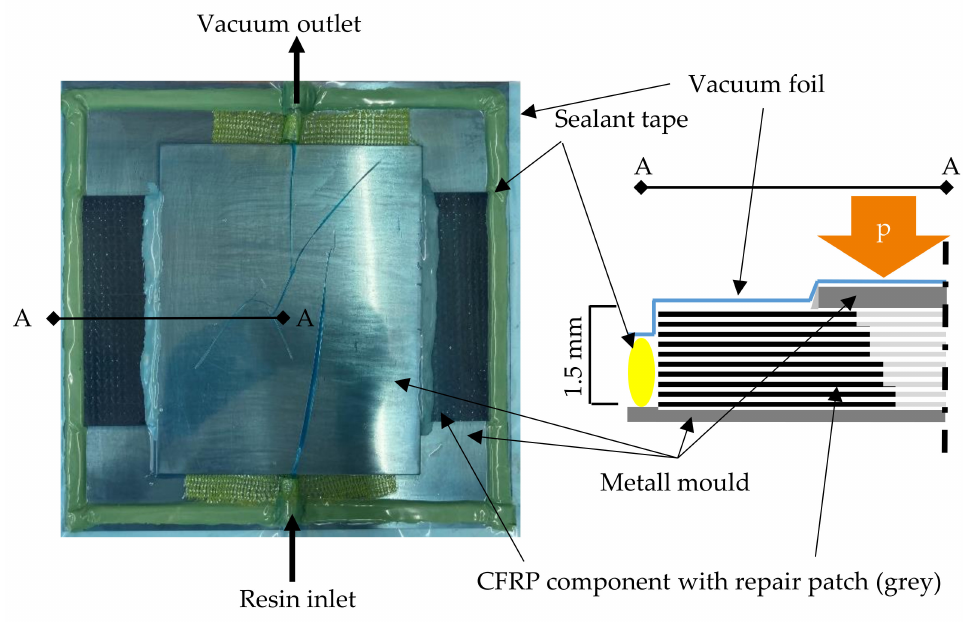
Figure 4. VARI re-infiltration setup for CFRP repair with textile patches. Within the study, CFRP plates (250 mm × 150 mm) have been used to develop and show the repair procedure. Therefore, in the middle of the plate (Figure 5, yellow dashed line), damage is realized by CNC milling of a 1.0 mm gap through the complete laminate thickness. In this way, the damaged samples do not have any residual load bearing capacity, and a good comparison to the undamaged ‘reference’ is possible. The CFRP plates prepared in this way are repaired by the ‘patch-repair’. The series that was prepared and tested on ten specimens (25 mm × 250 mm) from two CFRP plates can be seen in Figure 5. The patch length on the front (patch)-side of the sample is 160 mm.